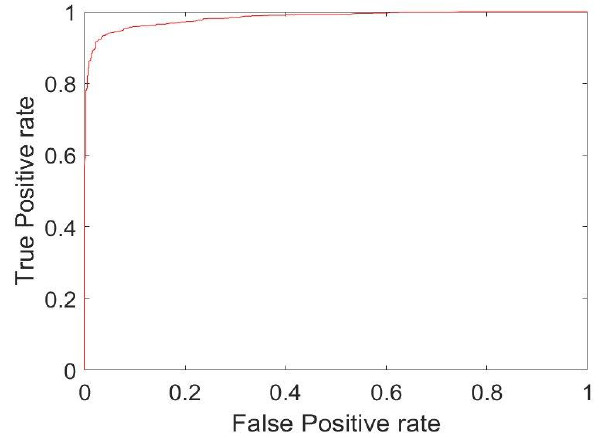
Figure 5. ROC (Receiver Operating Characteristic) curve of the best configuration.